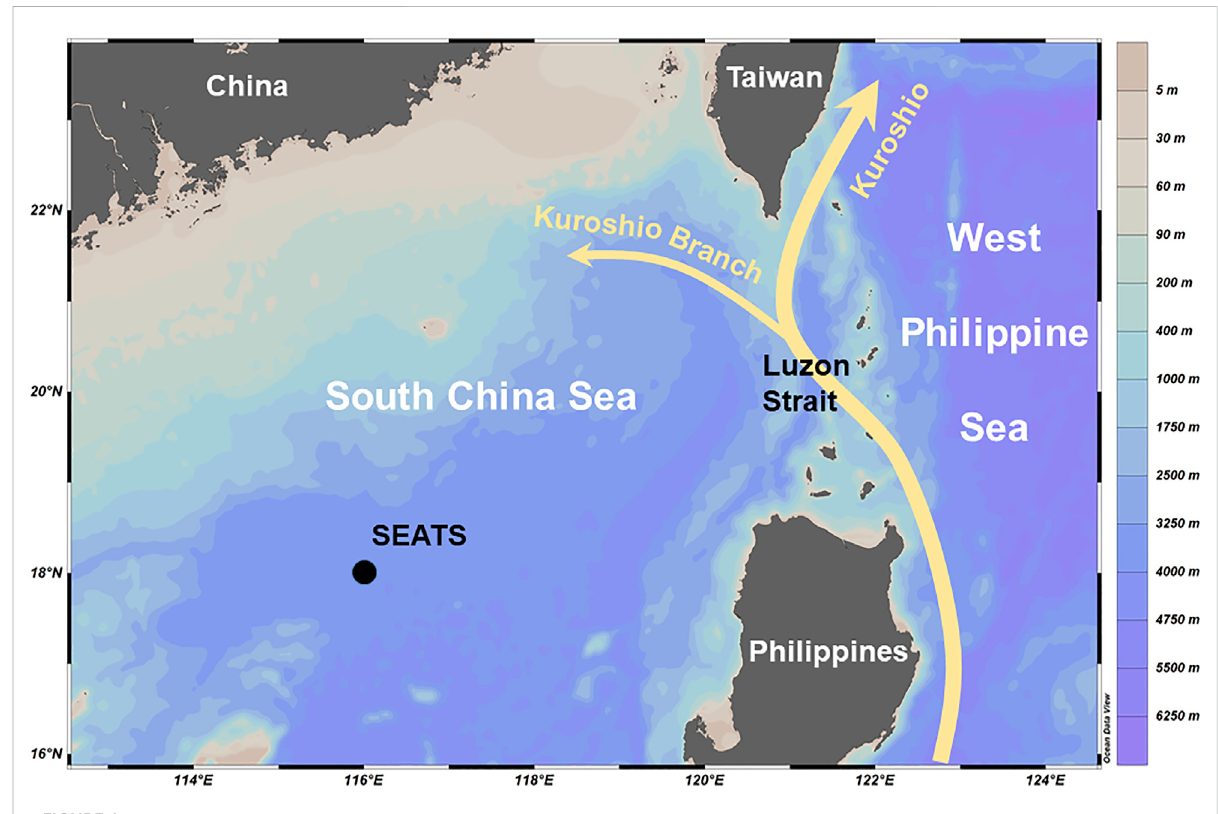
FIGURE 1 LocationmapforSEATStime-seriesstationandbasichydrology.ThecurvesandarrowsshowthetypicalKuroshiomainstreamandbranch.The map was generated using Ocean Data View 5.0.0. Schlitzer, R., Ocean Data View, https://odv.awi.de,